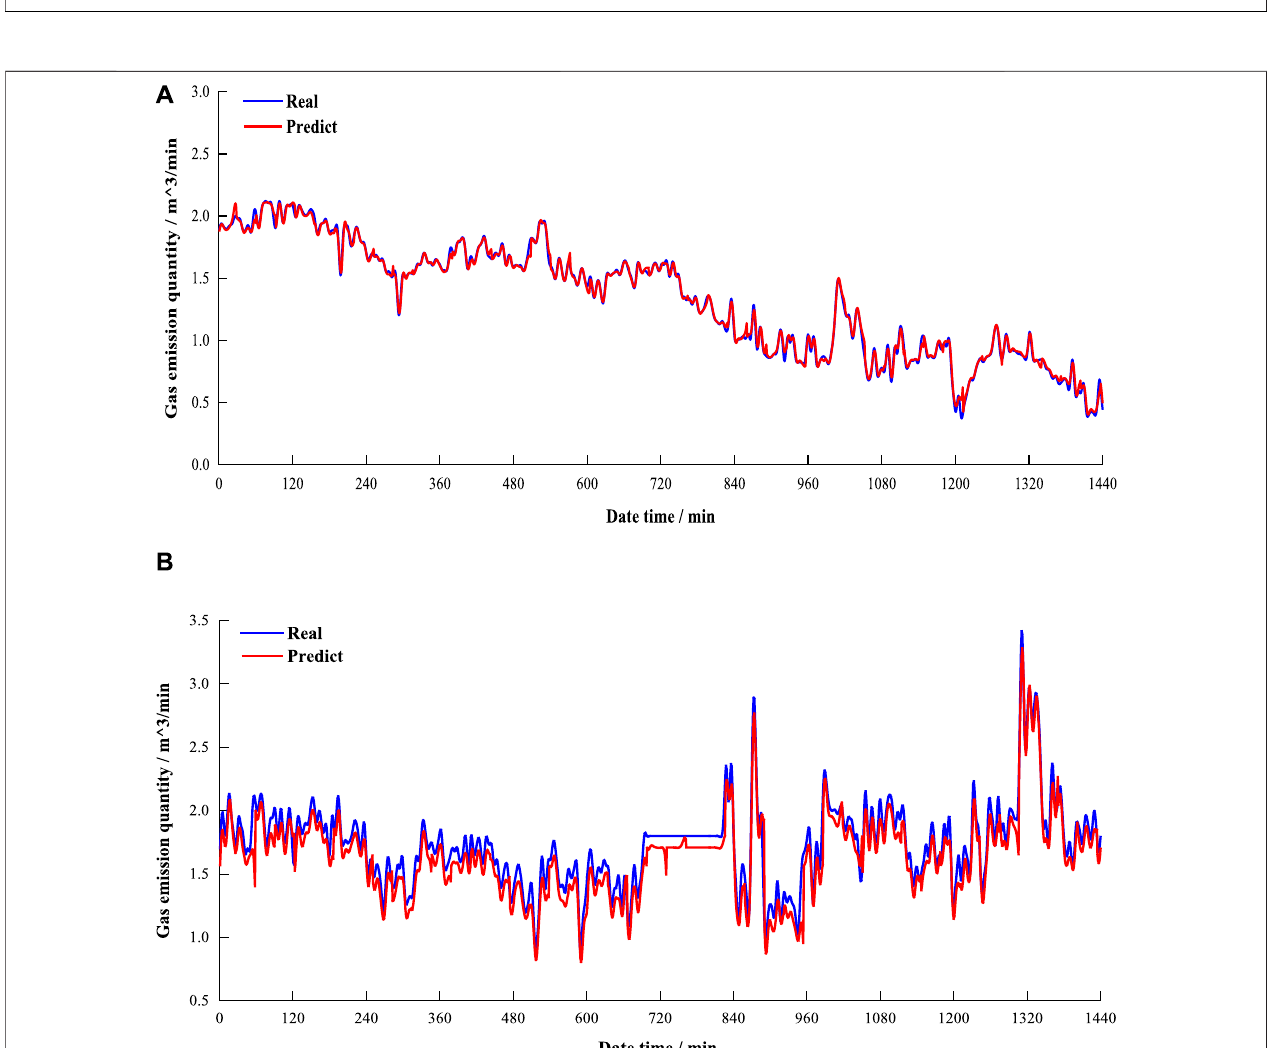
FIGURE 13 | Gas emission prediction based on Bi-LSTM. (A) Gas emission prediction in normal production (B) Gas emission prediction before the accident